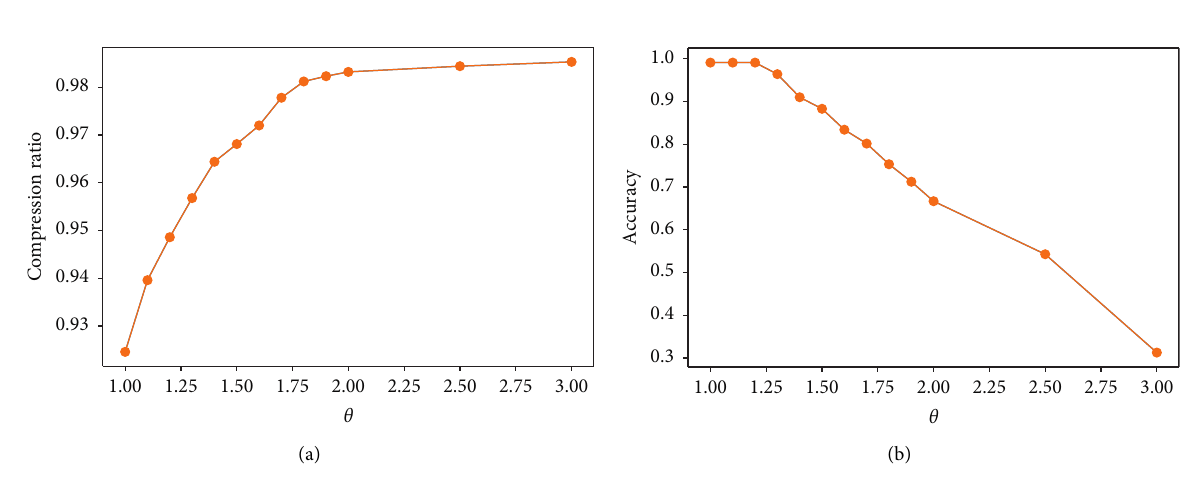
Figure 4: The compression ratio variations of different θ . Table 2: The information of two datasets used for experiments.